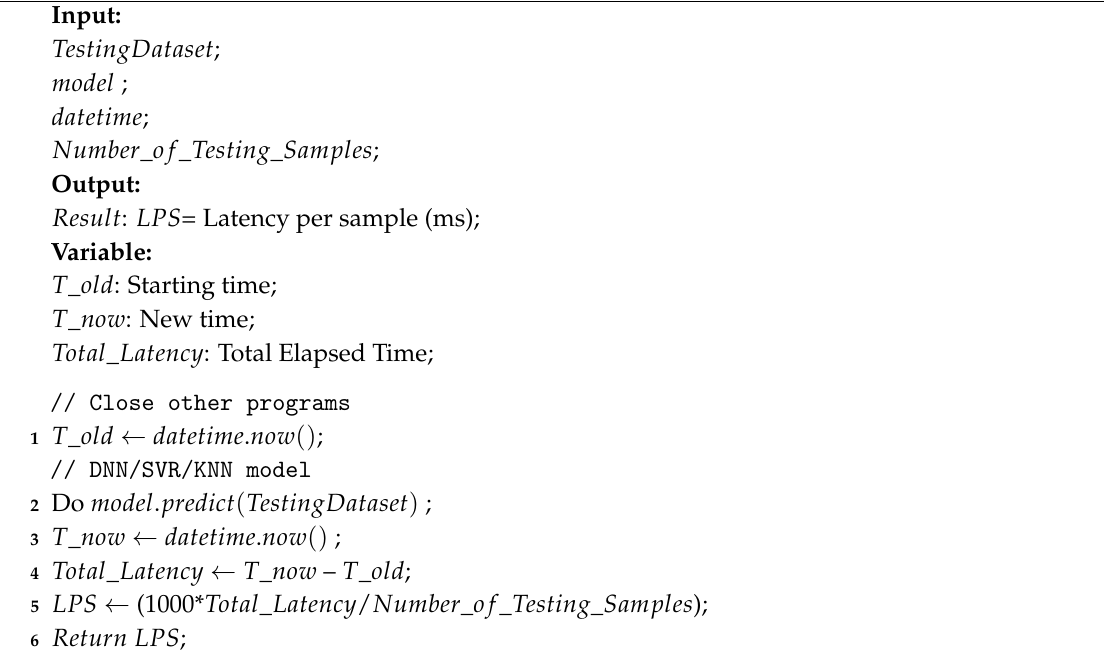
Algorithm 4 Latency (ms) measurement in edge and